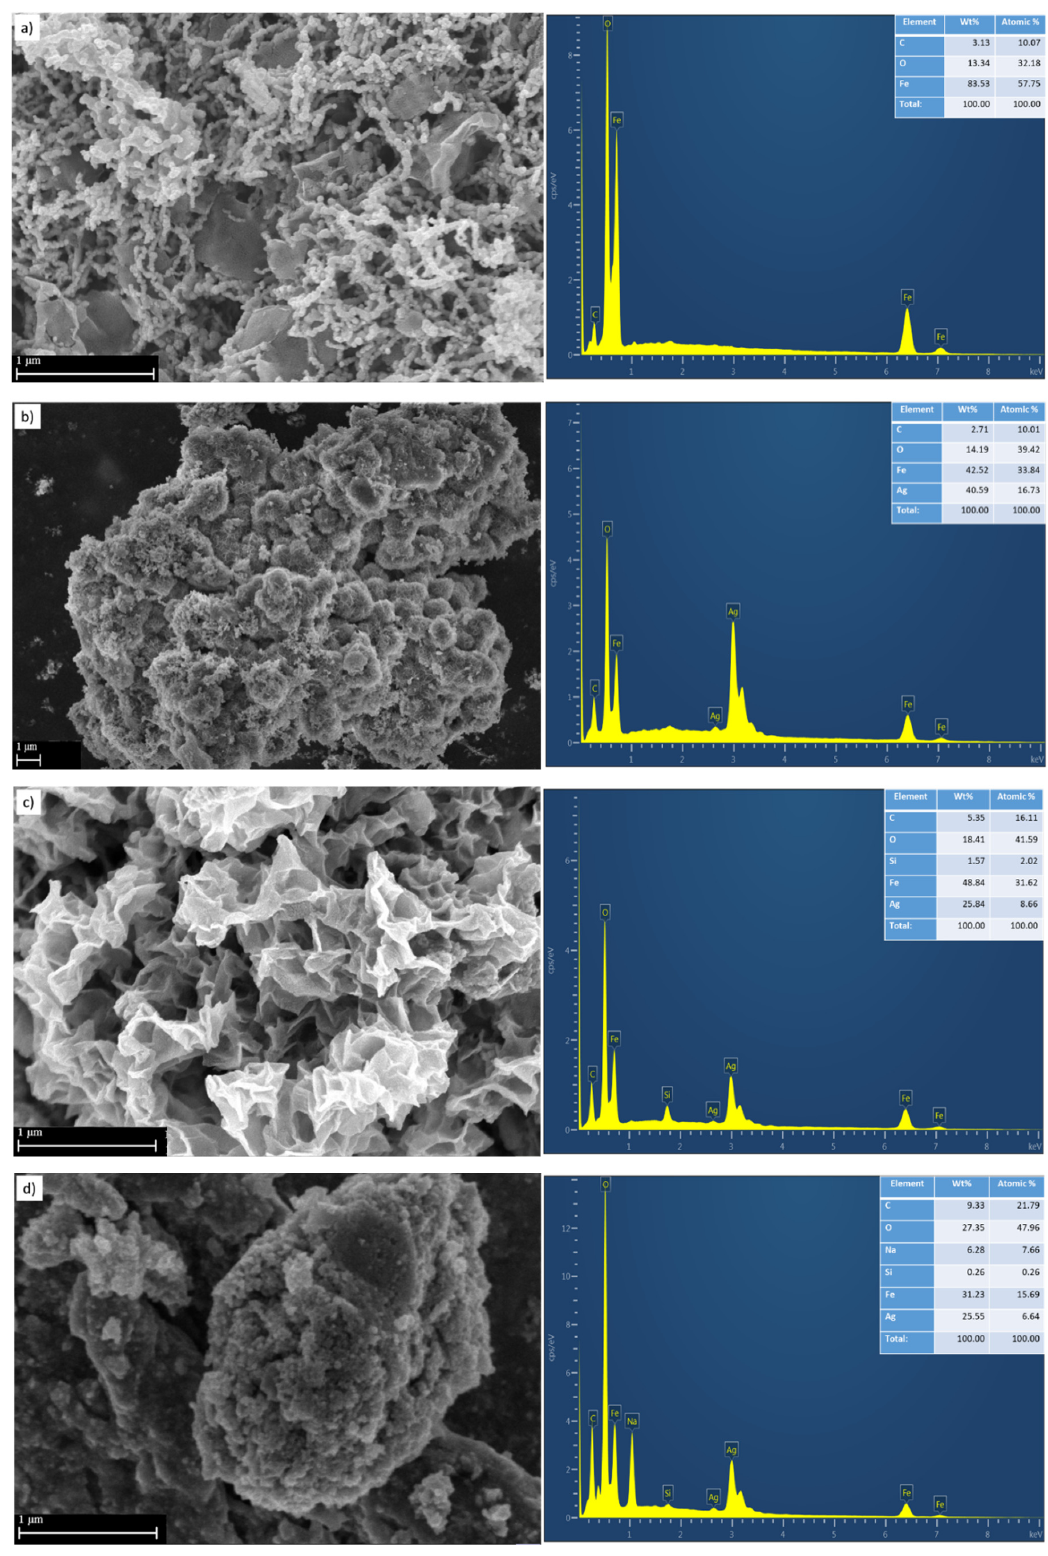
Figure 3. Scanning electron microscopy (SEM) micrographs and the elemental analysis using energy dispersive X-ray spectroscopy (EDX) of ( a ) synthesized Fe, ( b ) Ag/Fe, ( c ) APTES–Ag/Fe, and ( d ) PEI– Ag/Fe.